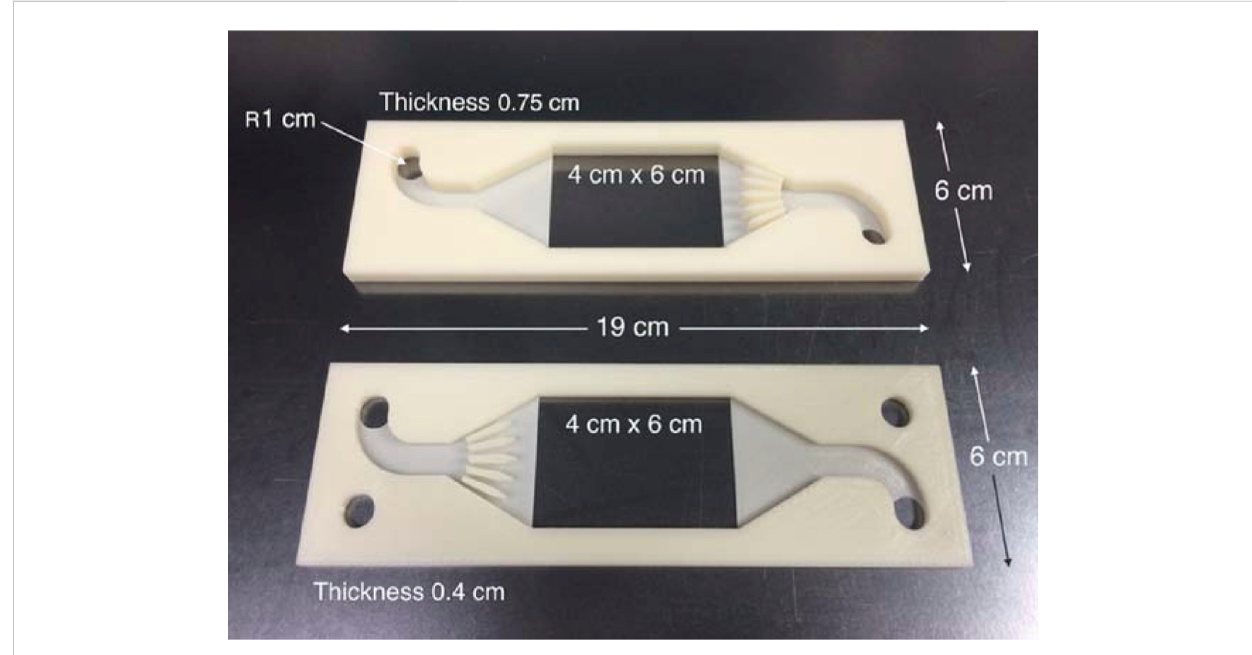
FIGURE 6 3D printed fl ow frames for uniform electrolyte fl ows in Zn-Ce Flow Battery. Reproduced under CC-BY-4.0 from Arenas et al. (2015; ref.